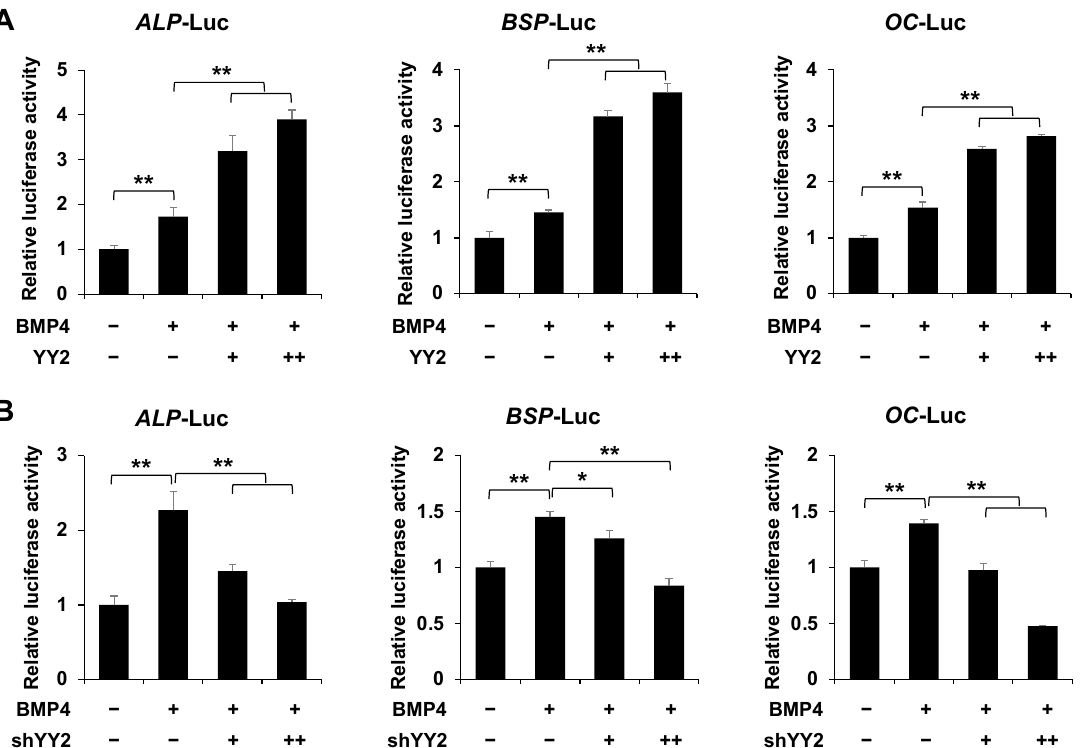
Figure 3. YY2 induces the expression of osteoblast-specific marker genes. C2C12 cells were transfected with ALP, BSP, and OC-Luc reporter genes (0.3 µ g), and β -gal (0.05 µ g), and increasing amounts of YY2 or shYY2, then treated with or without BMP4 for 36 h. ( A ) YY2 enhanced the promoter activity of ALP, BSP, and OC. ( B ) Knockdown of YY2 decreases the expression of osteoblast-specific reporters. Data are expressed as mean ± SEM of at least three experiments. * p < 0.05 and ** p < 0.01.